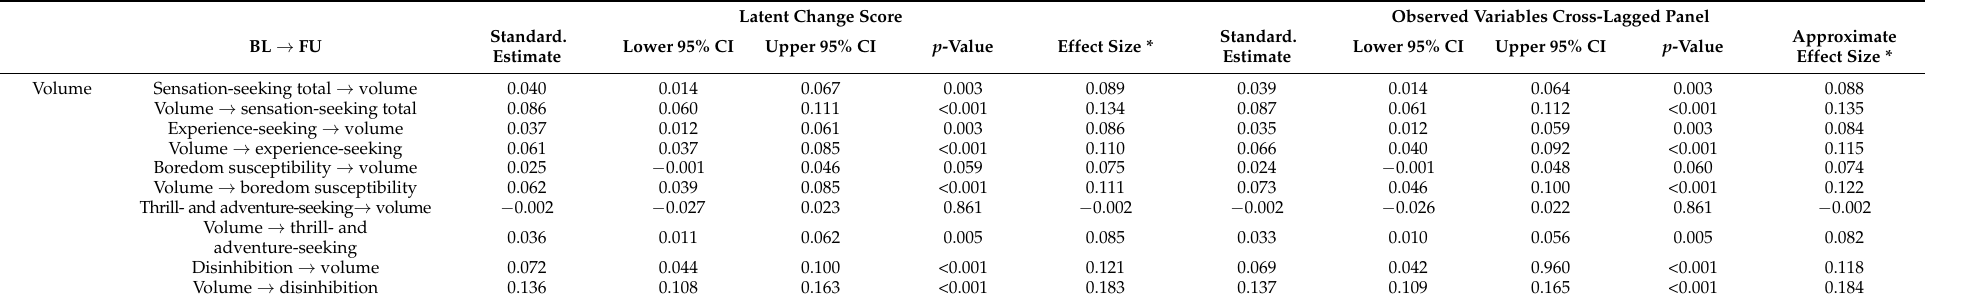
Table 4. Standardized path coefficients of cross-lagged models of drinking volume with only observed (right) and observed and latent change score variables (left). Latent Change Score Observed Variables Cross-Lagged Panel BL → FU Standard. Estimate Lower 95% CI Standard. Estimate Approximate Effect Size * Volume Sensation-seeking total →